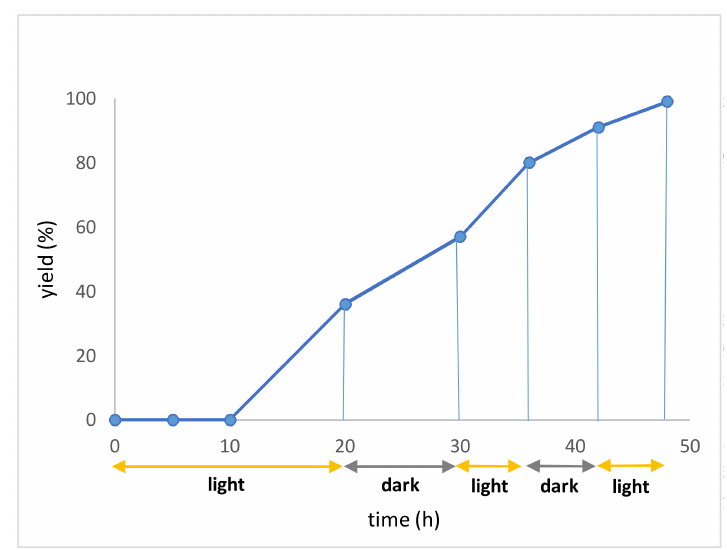
Figure 1. Light-dark cycle experiment with N -[(pentyl-2-carbonyl)oxy]phthalimide (0.3 mmol), isoquinoline (0.2 mmol) and p -toluenesulfonic acid (0.3 mmol) in DMF (0.1 M). The reaction mixture was irradiated for certain times with a 100 W blue LED module (emission spectra see Supporting Information, Figure S2) and the yield was determined by NMR spectroscopy with 1,4-bis-(trimethylsilyl)benzene as an internal